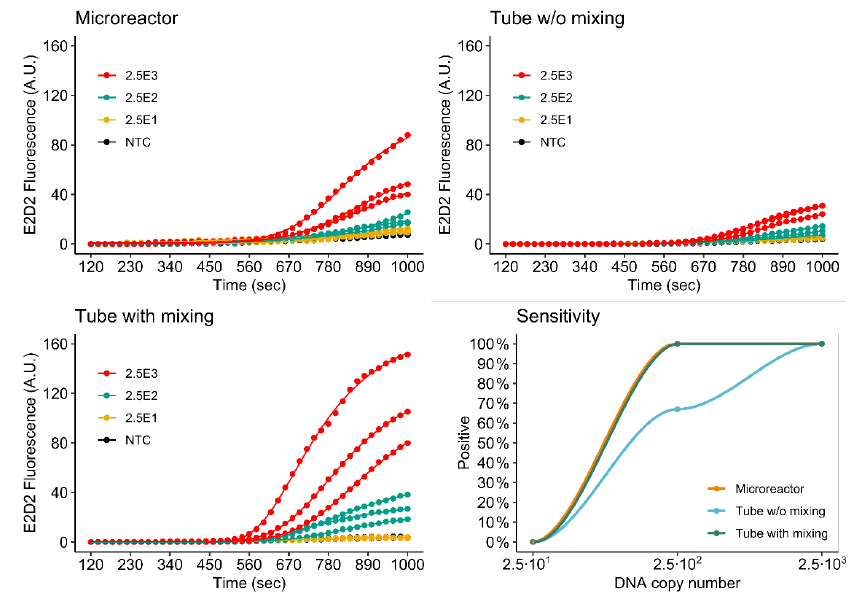
Figure 12. Detection of bla NDM-1 by duplex rtRPA.